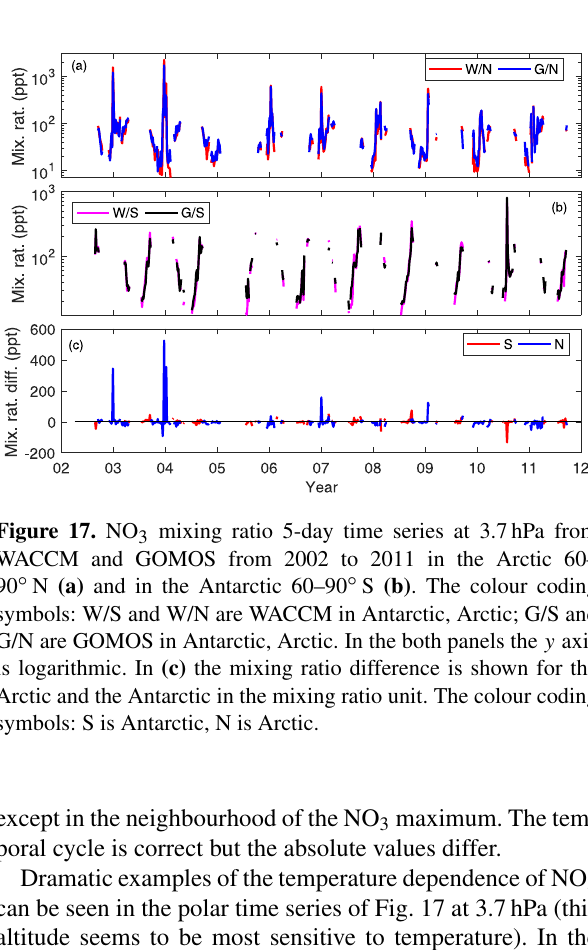
Figure 16. WACCM and GOMOS NO 3 mixing ratio correlation for 2002–2011. Latitudes are from − 90 to 90 ◦ with 10 ◦ resolution. A crossed cell marks a point where the correlation does not deviate from zero in a statistically significant way. A cell with a dot marks a point where there are no collocated profiles.